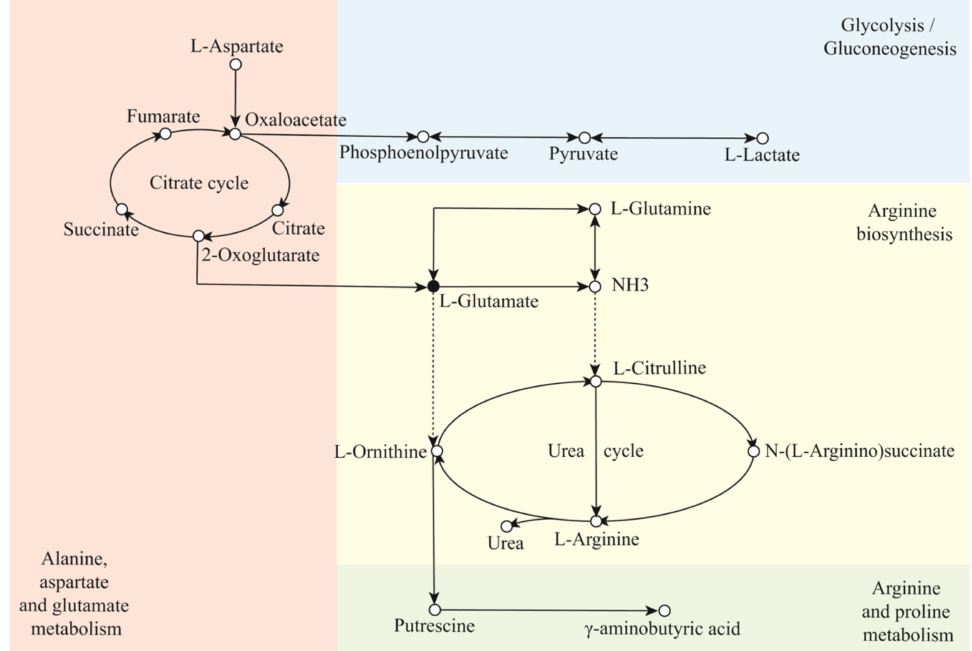
Figure 5. Integrated analysis diagram of the main metabolic pathways in ultra-long-term industrially fermented kohlrabi.